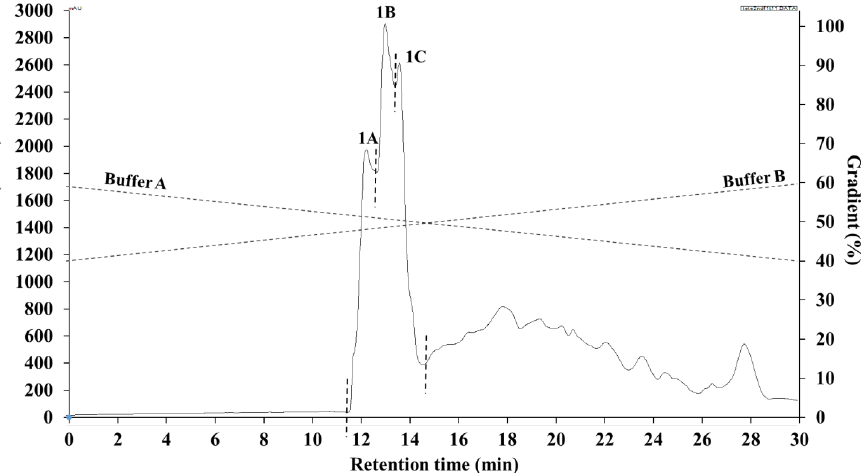
Figure 3. Separation of fraction P1 by second round of reversed-phase (C12) HPLC into 1A, 1B, and 1C sub-fractions.